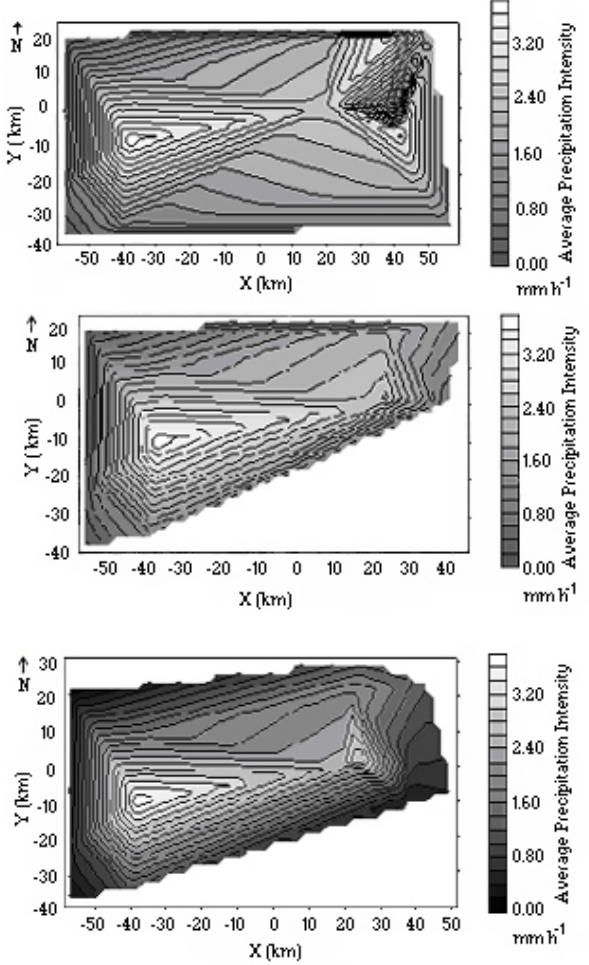
Fig. 6. The main precipitation period: (a) average precipitation intensity of radar estimated, (b) average precipitation intensity of CG lightning estimated, (c) the real average precipitation intensity measured by rain gauges; unit is mm/h